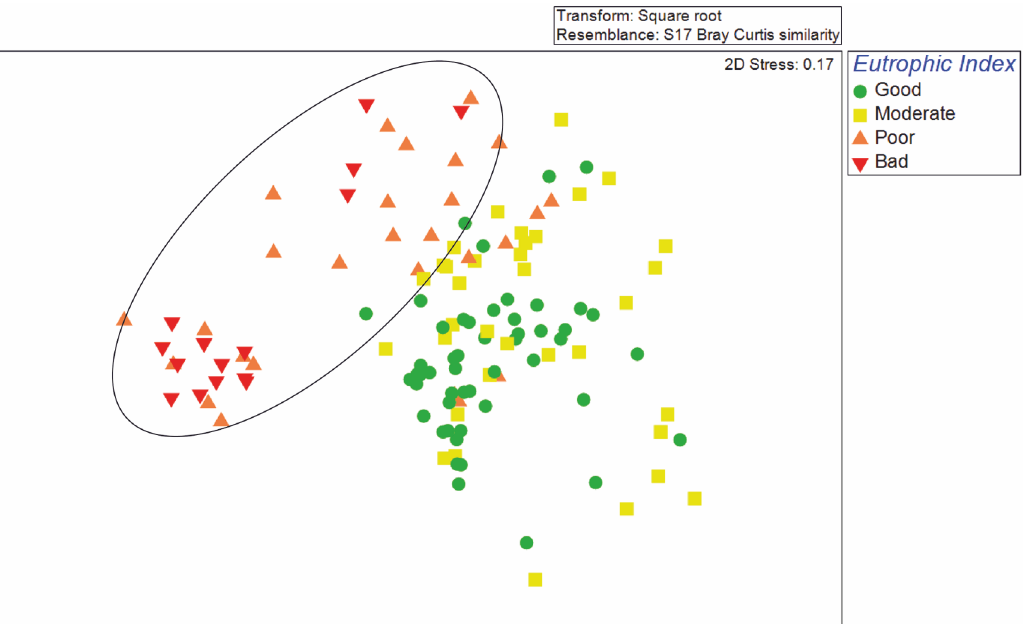
Fig 1. Non-metric multi dimensional scaling (nMDS) plot of macrobenthic data but with stations labeled after the Ecological Status defined by means of the Eutrophic Index in the overlaying water column.